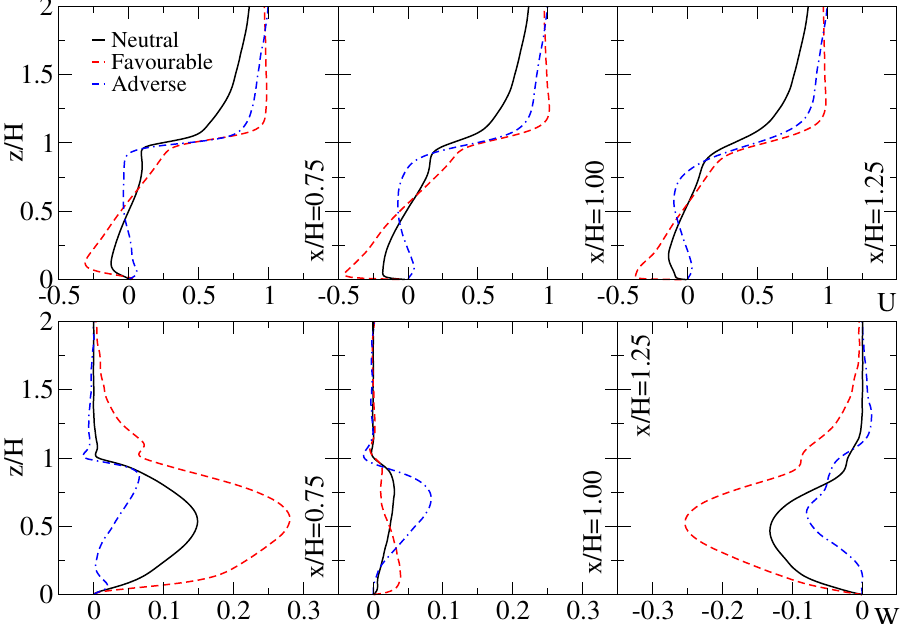
Figure 5. Non-dimensional mean velocity components, U = (cid:104) u (cid:105) / U 0 and W = (cid:104) w (cid:105) / U 0 , along three selected vertical lines x / H =